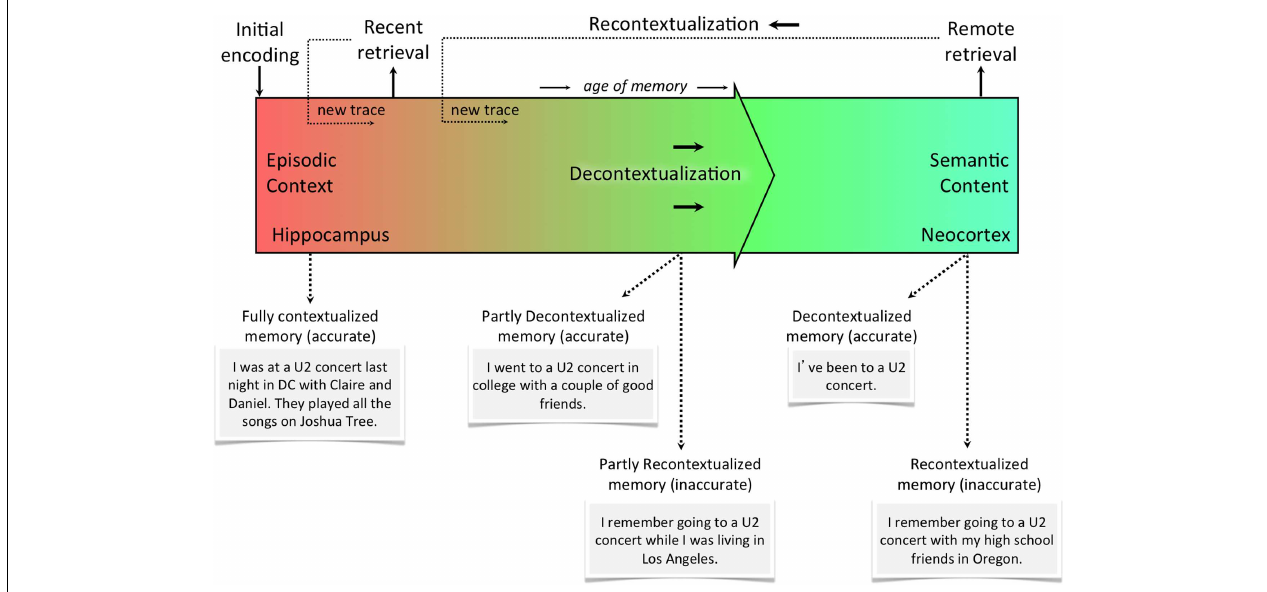
ones.This means memories recalled from the distant past could either be decontextualized and accurate or recontextualized and inaccurate. Of course, neither accuracy or contextualization is a categorical assignment for the memory, but rather each memory can be described in terms of the accuracy of its details and the degree to which they are contextual (i.e.,